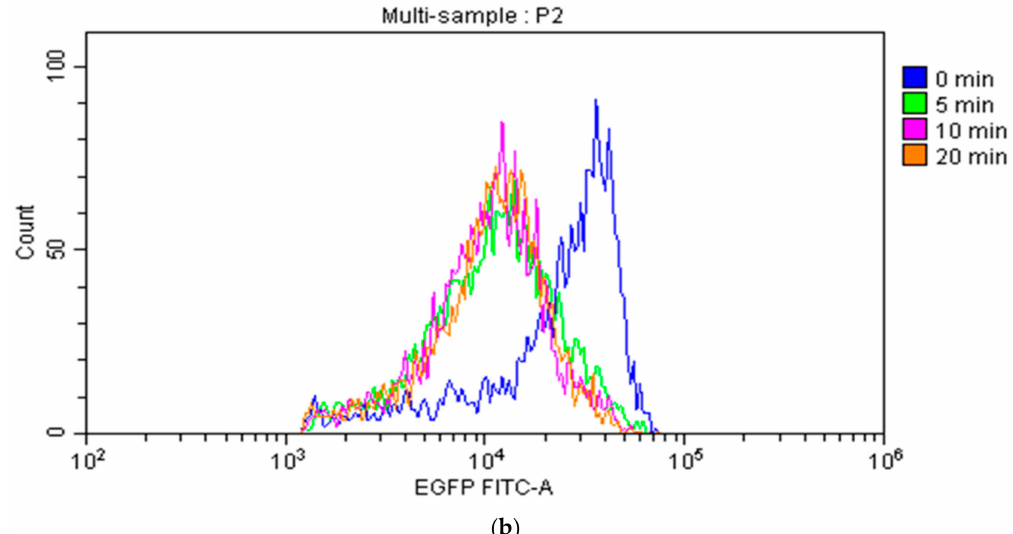
Figure 4. Changes in the fluorescence intensity of E. coli cells by chlorine at ( a ) pH 7 and ( b ) pH 9. Each histogram of 5000 gated events is shown as counts versus the log of fluorescence intensity. The color before chlorination is shown in blue and the colors after chlorination are shown in other colors for each treatment